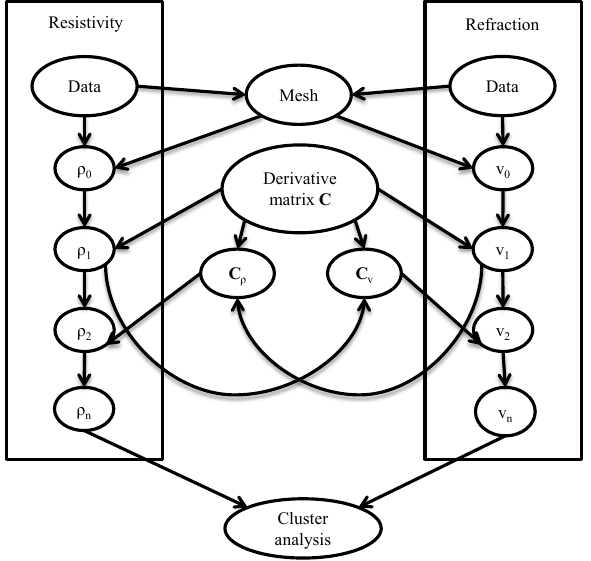
Figure 2. Scheme of the coupled inversion approach, where the roughness C of one inversion is influenced by the other (Günther et al., 2006a).